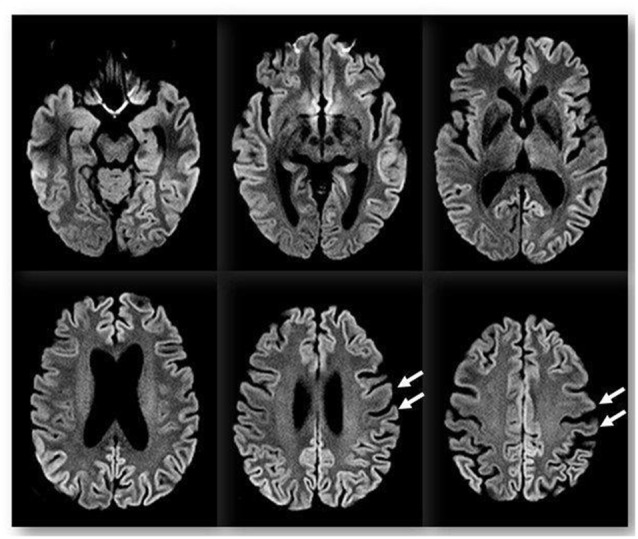
Brain magnetic resonance imaging (MRI). Diffusion-weighted imaging (DWI) with b value of 1,000 s/mm2 showing bilateral and diffuse supratentorial cortical diffusion signal changes with a restriction on ADC map (not shown) and slight left lateralization. The peri-rolandic cortex is spared (arrows). There is no involvement of subcortical structures.